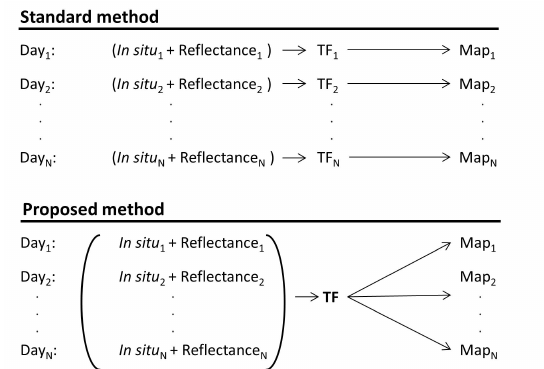
Figure 2. Standard method for derivation of high-resolution reference maps building a transfer function per available measuring date ( up ), and the proposed method made with a multitemporal data set ( bottom